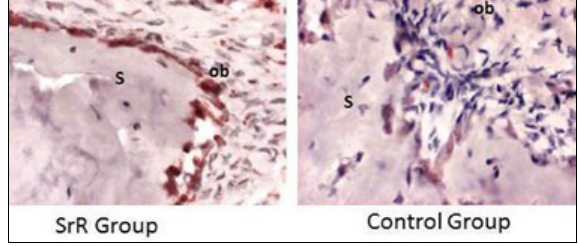
Figure 6. Photomicrographs of immunohistochemical sections from sutural areas stained with anti-TGF- β antibody. Ob: Osteoblastic activity; S: Sutura connective tissue (40× magnification).